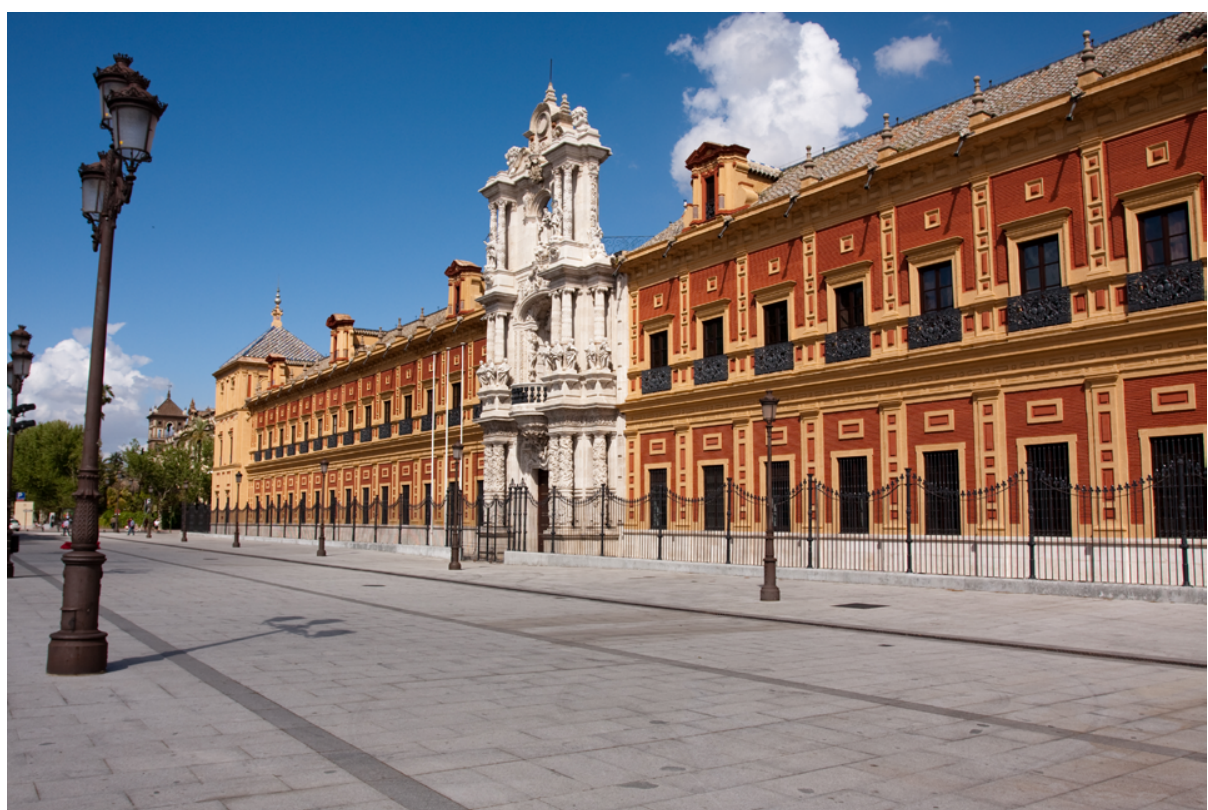
Figure 13: The exterior of the former naval college of San Telmo. Image from https://www.flickr.com/photos/ elgris/4648525090. Copyright José Estepa (Creative Commons